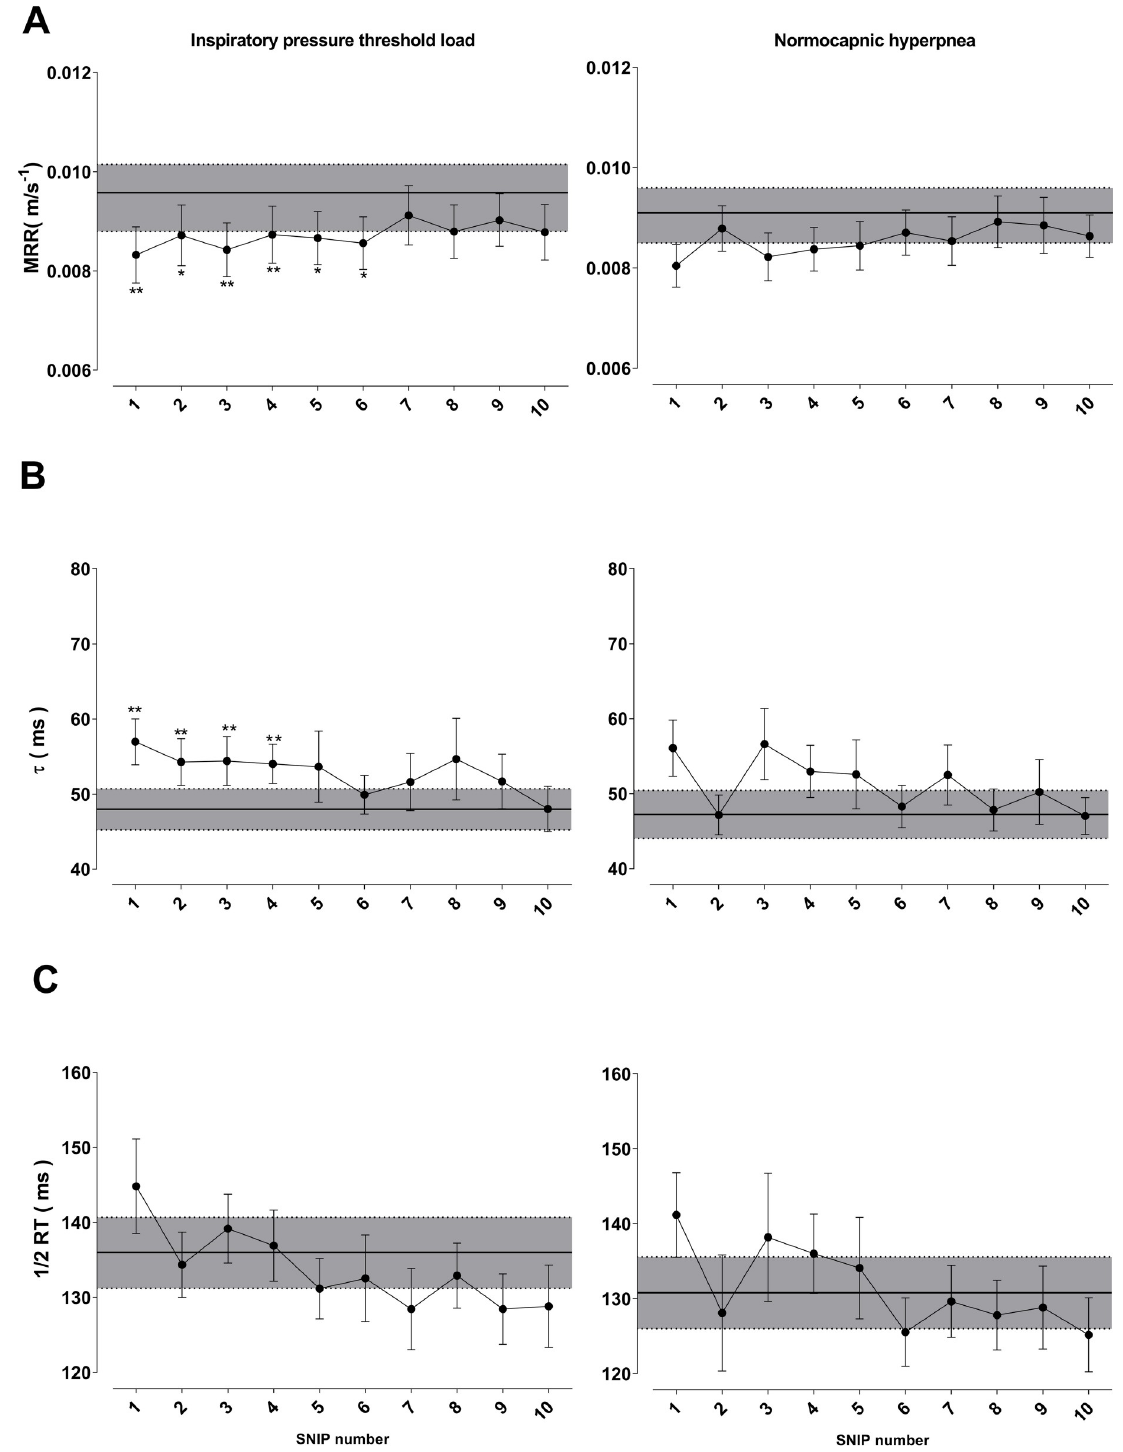
Fig 4. Changes in maximum relaxation rate (MRR-panel A), time constant (tau) of relaxation curve ( τ -panel B), and time to reach half of relaxation curve ( ½ RT-panel C). Comparison of values during recovery from endurance test and pre-test (gray band). Data presented as mean ± SE. Abbreviation: ms: milliseconds. � Statistically significant intragroup difference between pre-test and recovery p < 0.05 �� Statistically significant intragroup difference between pre-test and recovery p < 0.01.